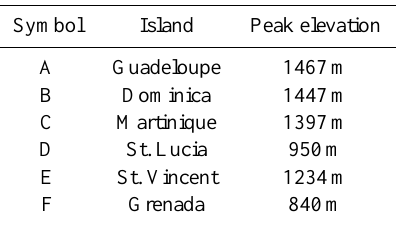
Table 1. Peak elevations of the major islands in the Lesser Antilles